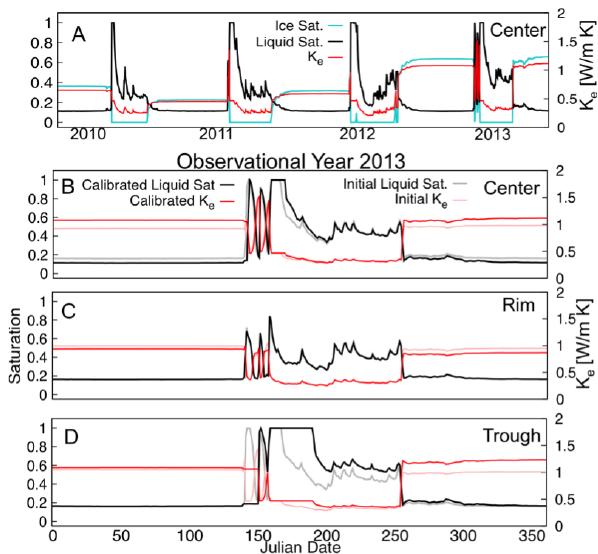
Figure 10. Ice and liquid saturation are shown in (a) for the sim- ulated years of 2010–2013 at 2cm depth along with bulk thermal conductivity for a center column. Notice that ice saturation and ther- mal conductivity during the winters are unique for each simulation year. (b) is a detailed view of year 2013 of ice and liquid saturation and the bulk thermal conductivity for the center. (c) and (d) show the corresponding ice and liquid saturations for the trough and rim, along with the respective thermal conductivities for the 2cm soil depth for the year 2013. (b) – (d) have unique ice and liquid satura- tion and therefore bulk thermal conductivity for each column, which is a result of both the maximum ponded depth for each column and the snow distribution that mimics wind scouring of the snow surface at Barrow,